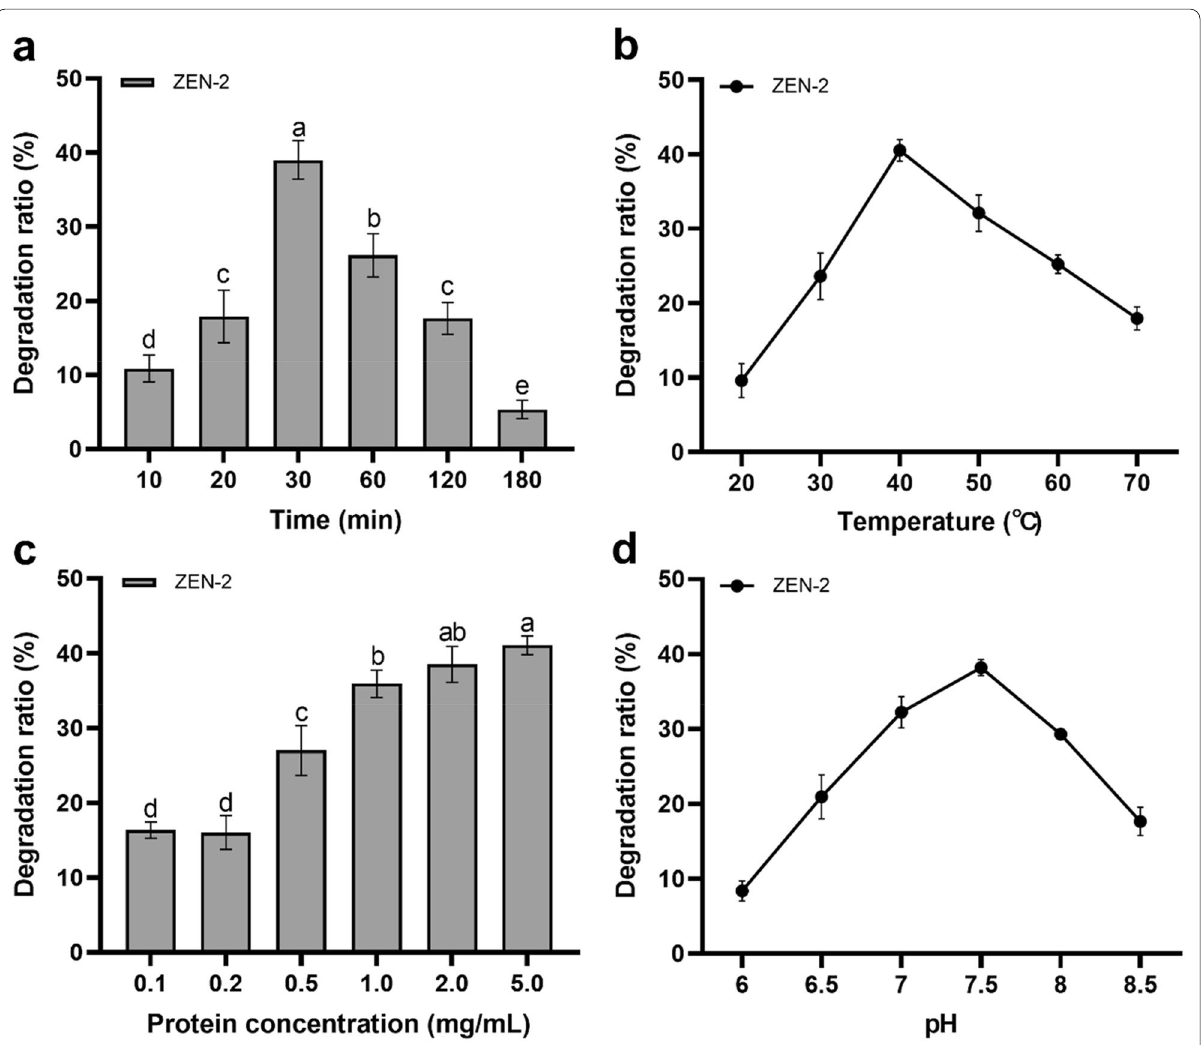
Fig. 5 Degradation of ZEN by ZPF1 under different conditions in reaction system 2. a–d were the effects of time, temperature, protein concentrations and pH of buffer. Different letters above the histogram were significant differences ( p <